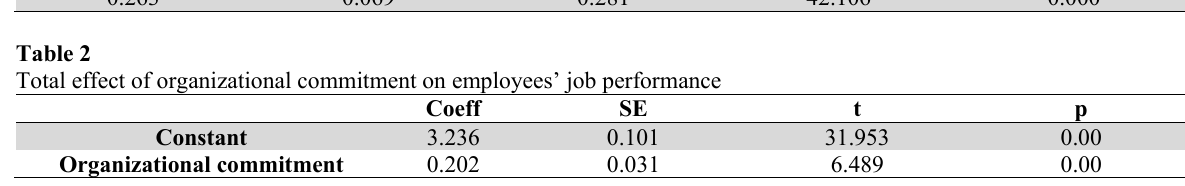
Model Summary for effect of organizational commitment on employees’ job performance R